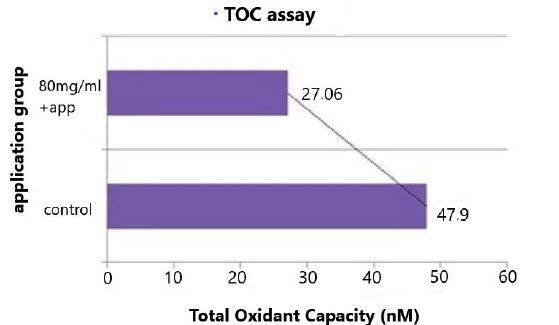
Figure 3 - Quantitative analysis of total oxidant status (TOS) of Caco-2 cells treated with 80 mg/ml of P. russeliana crosscheck with untreated group up to 48 h